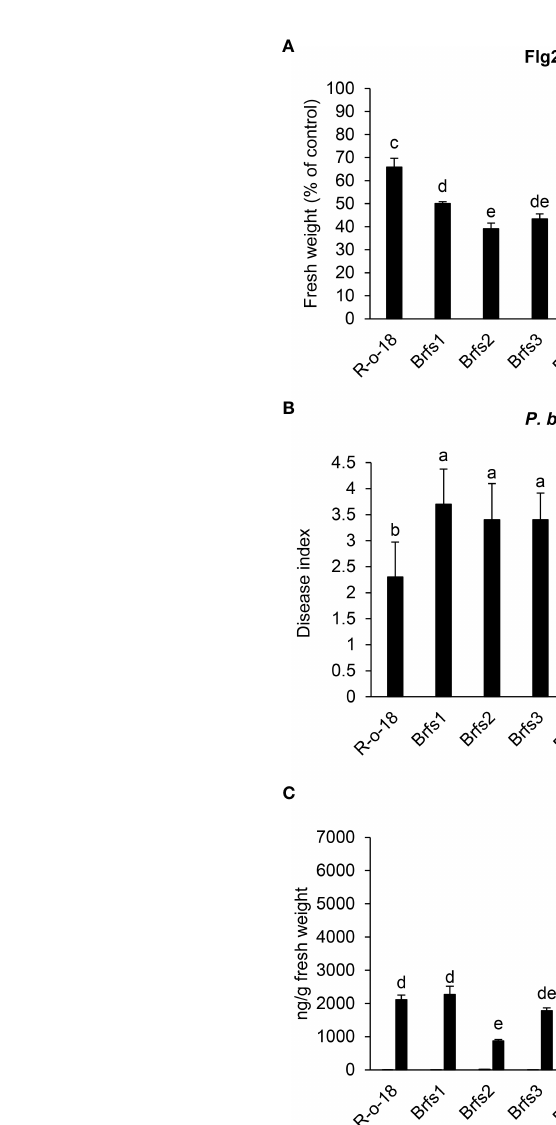
FIGURE 2 Phenotypes of Br fs and Br fi n lines during fl g22- or P. brasiliense - triggered signaling. (A) Effects of fl g22 on the growth of Br fs and Br fi n lines. Six-day-old seedlings Br fs, Br fi n lines and R-o-18 were incubated for an additional 6 days in plates containing Murashige and Skoog (MS) agar medium with or without 10 µM fl g22. (B) Relatively strong resistance of Br fi n lines to the soft rot pathogen P. brasiliense. 24-day-old B. rapa plants were inoculated with P. brasiliense KACC 10225 by drenching the proximal plant parts with a bacterial suspension (1 × 10 6 CFU/mL). At 7 days post-inoculation, disease severity was evaluated on a 0-4 scale and then converted to a percentage. Error bars represent standard deviations of 30 replications. Similar results were obtained in at least two independent experiments. Different letters indicate signi fi cant differences among plant genotypes ( a = 0.01, one-way ANOVA and Duncan test; SPSS software). (C) Endogenous and P. brasiliense -induced phytohormone contents in B. rapa inbred lines. The JA contents in the control and infected leaves were quanti fi ed at 24 h post-infection. Error bars represent standard deviations of fi ve replications. Similar results were obtained in at least two independent experiments. Different letters indicate signi fi cant differences among plant genotypes ( a = 0.05, one-way ANOVA and Duncan test; SPSS